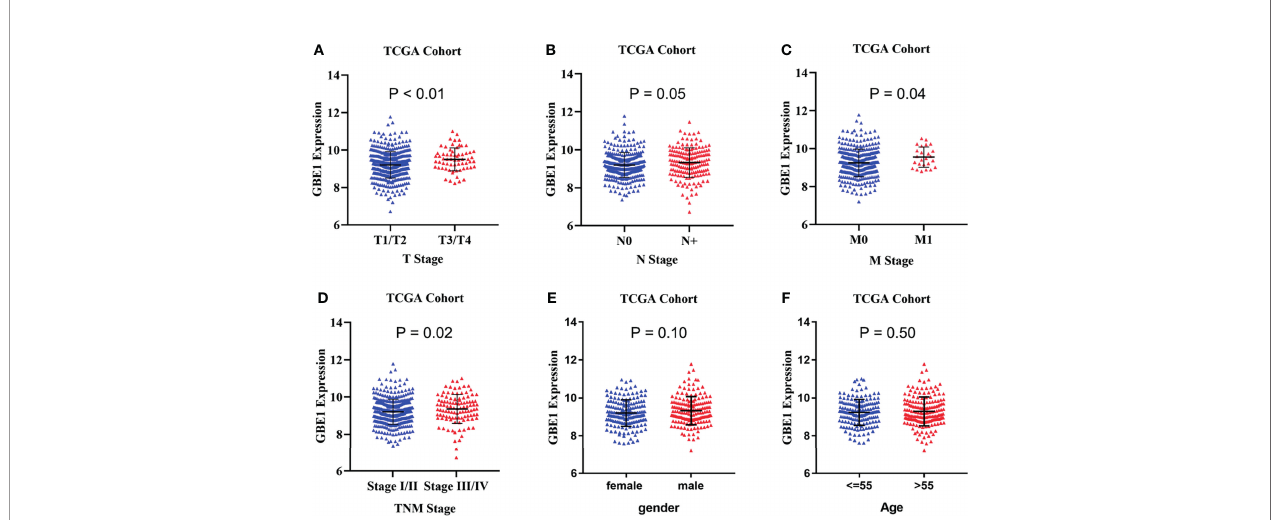
FIGURE 4 | TThe correlation analysis between GBE1 expression and different clinical characteristics in LUAD via TCGA cohort. (A) The correlation analysis between GBE1 expression and T stage. (B) The correlation analysis between GBE1 expression and N stage. (C) The correlation analysis between GBE1 expression and M stage. (D) The correlation analysis between GBE1 expression and TNM stage. (E) The correlation analysis between GBE1 expression and gender. (F) The correlation analysis between GBE1 expression and age.